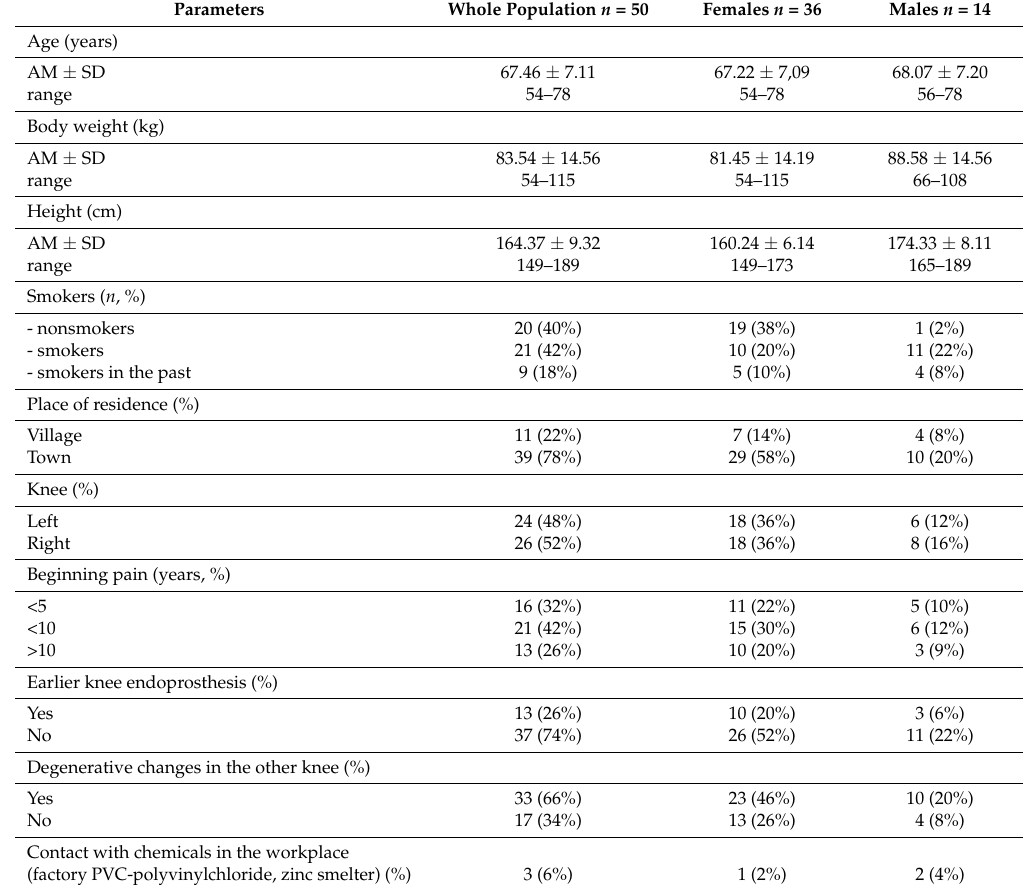
Table 1. Information about the study group patients (AM-arithmetic mean, SD-standard